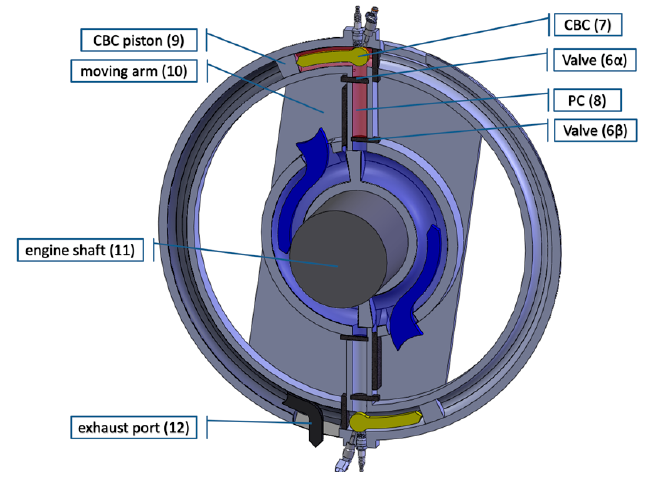
Figure 2. SARM engine operating Figure 2 . SARM engine operating phases